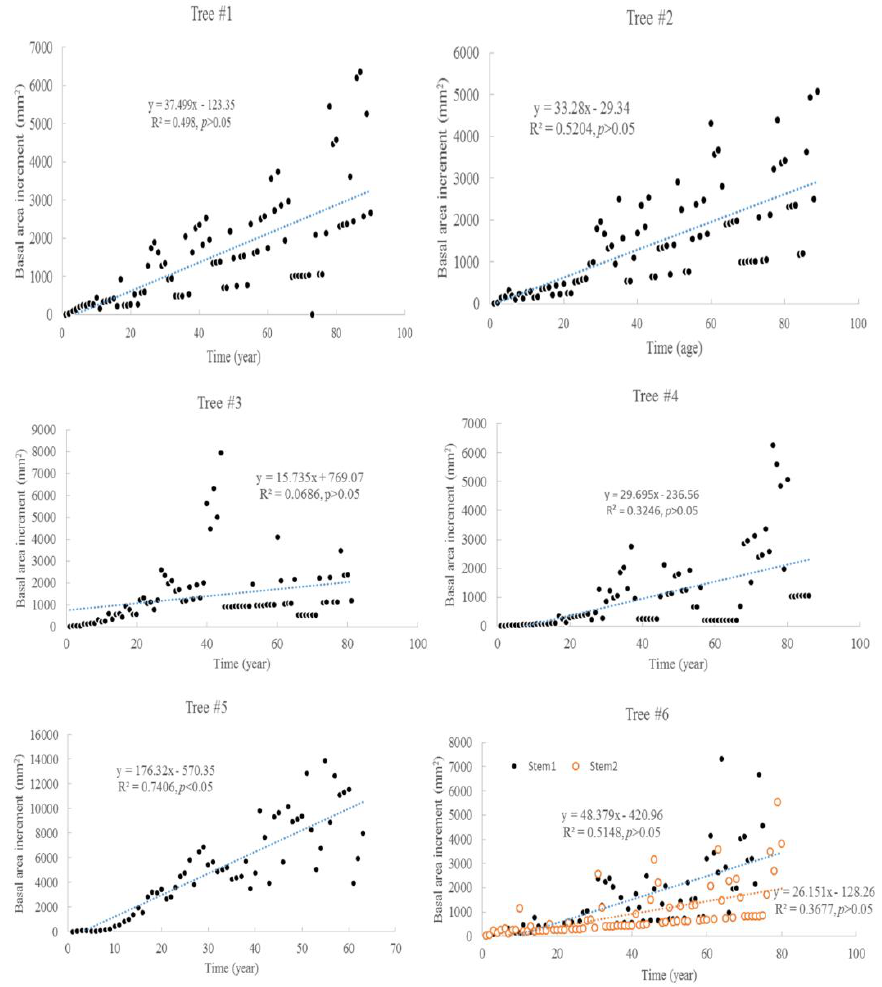
Figure 2. Basal area increments (BAI) change with time for six Chinese Torreya trees.